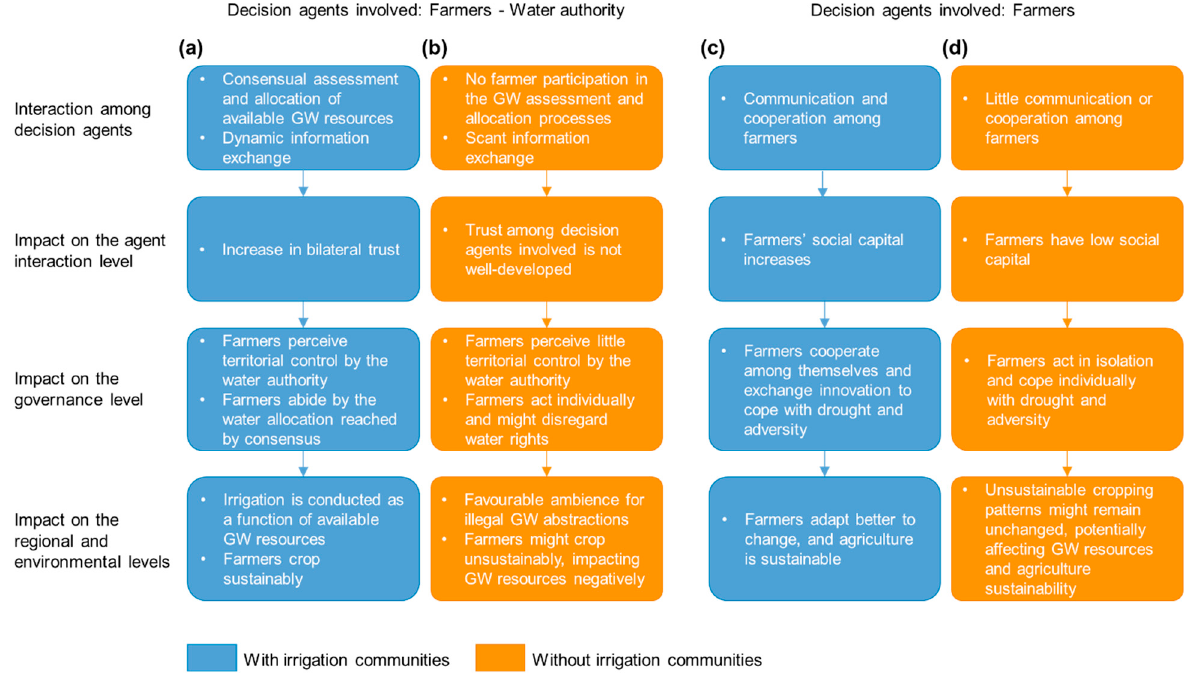
Figure 8. Interaction between farmers and the water authority and the ensuing impacts at various levels when irrigation communities (ICs) are implemented ( a ) and when they are lacking ( b ). Interac- tion among farmers and the subsequent effects at different levels with access to ICs ( c ) and without this access ( d ). GW: